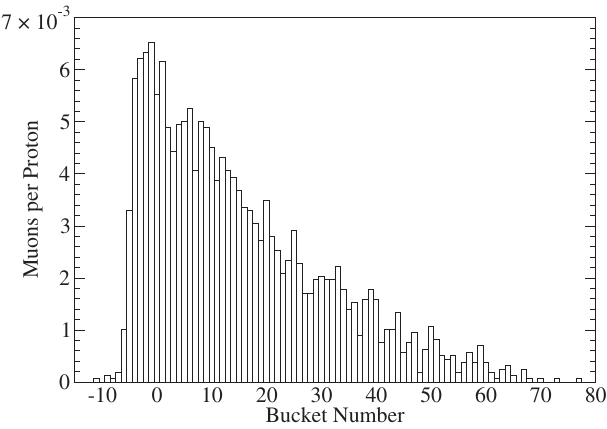
FIG. 16. Bunch structure of the beam delivered to the accel- erator normalized transverse acceptance of A normalized longitudinal acceptance of A momentum cut 0 : 1 (cid:10) p (cid:10) 0 : 3 GeV =c